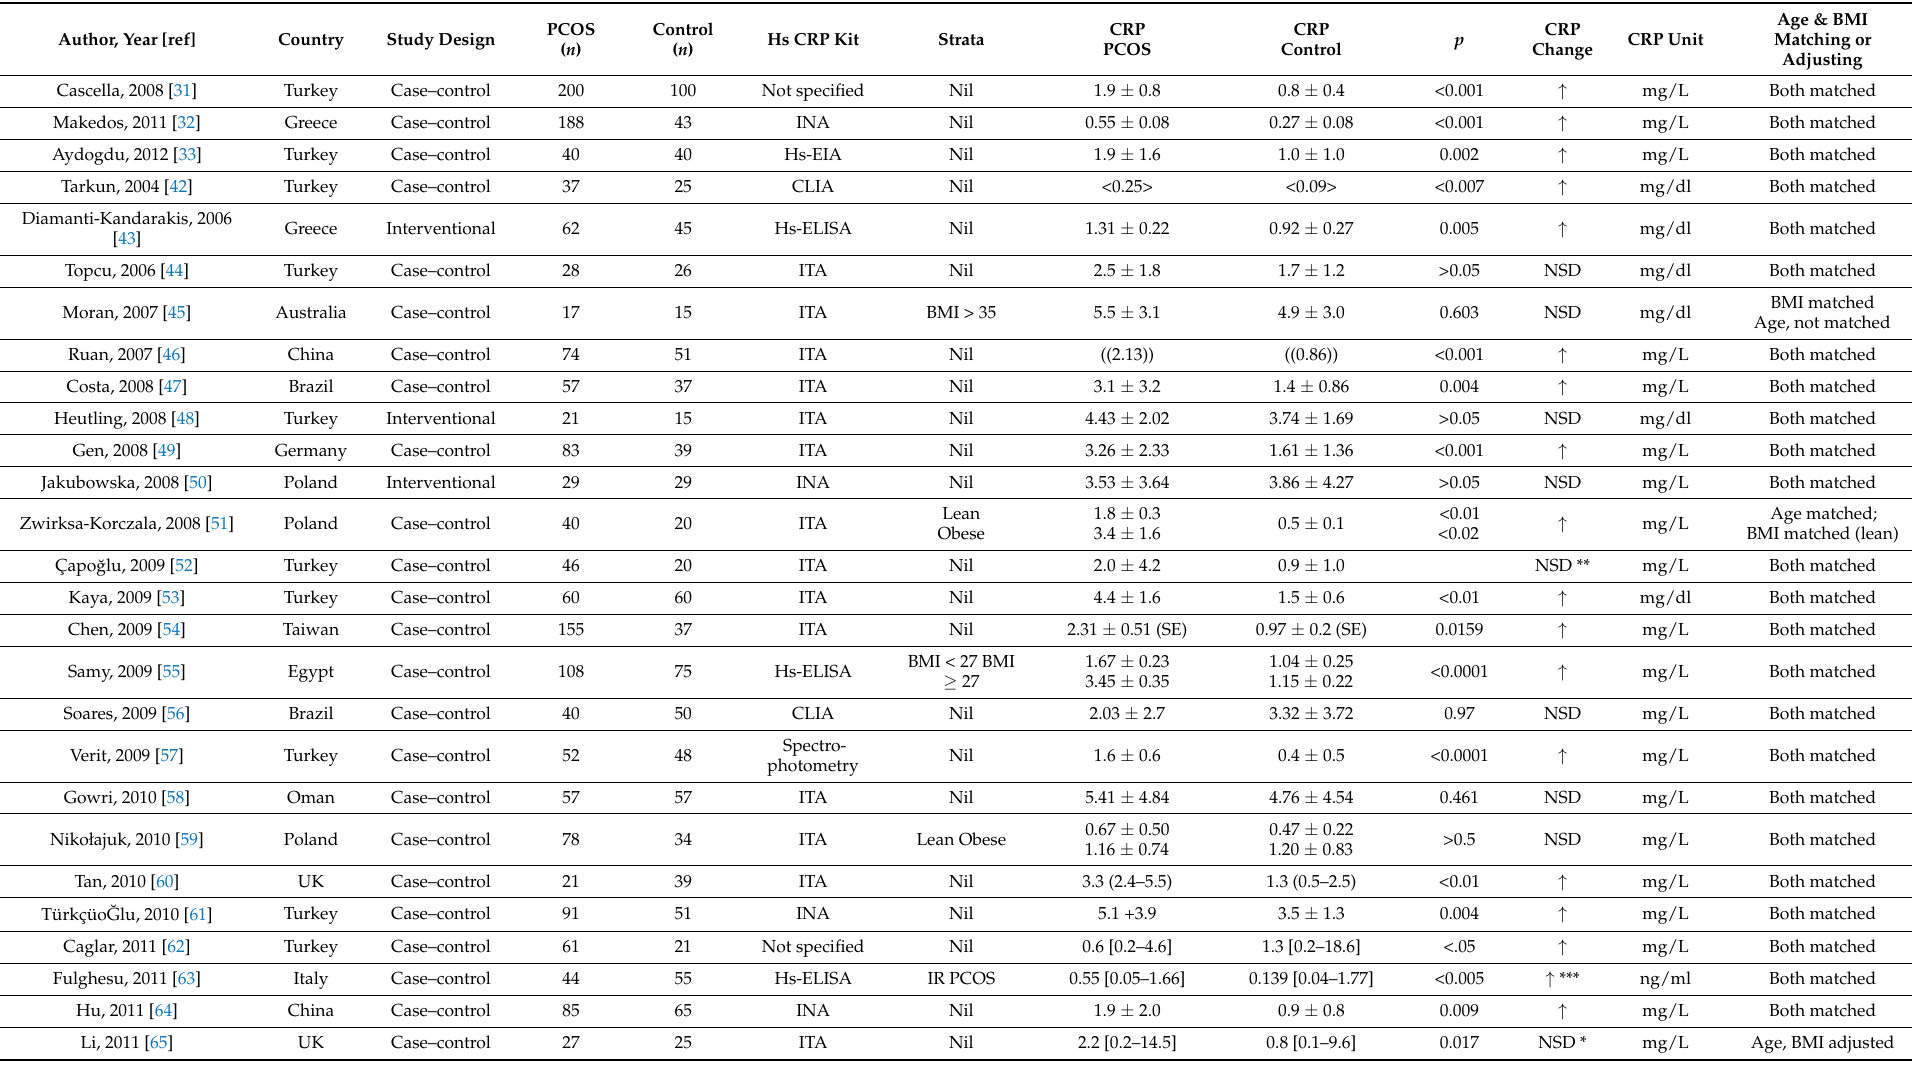
Table 2. Characteristics and CRP results of 85 studies included in the systematic review and